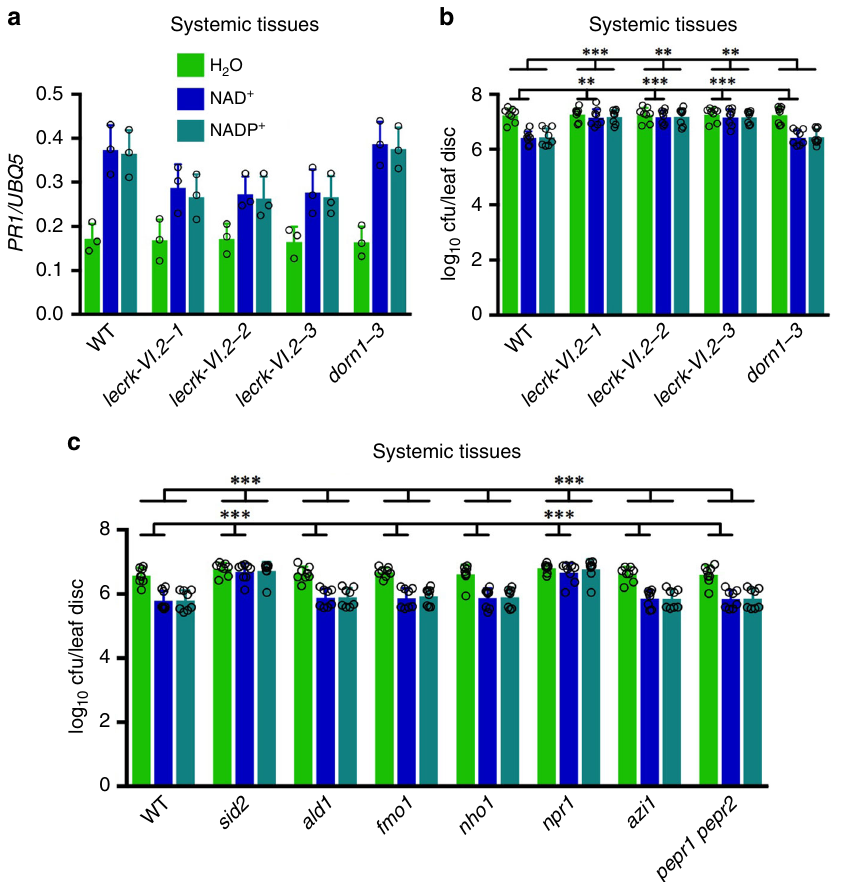
Fig. 3 Exogenous NAD(P) + -induced systemic responses in lecrk-VI.2 and several SAR mutants. a , b NAD(P) + -induced systemic PR1 expression a and systemic resistance b in the wild-type (WT), lecrk-VI.2 , and dorn1-3 plants. Three lower leaves on each 4-week-old soil-grown plant were in fi ltrated with H 2 O, 0.4 m M NAD + , or 0.8 m M NADP + every 12 hr for a total of four times. About 5 hr after the last in fi ltration, two systemic leaves were either